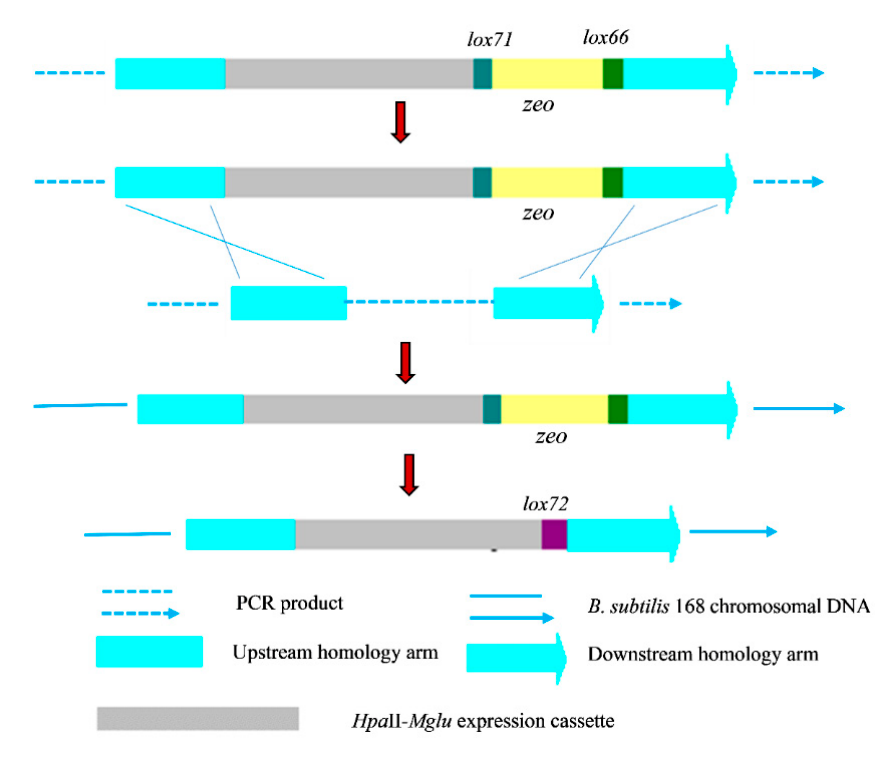
Figure 7. Strategy for integrating the Mglu gene in the B. subtilis 168 chromosome. An integrative fragment contained the lox71 - zeo - lox66 cassette with two regions having homology to the B. subtilis 16 chromosome and the Hpa II- Mglu cassette. Due to the homologous regions that flank the lox71 - zeo - lox66 cassette and the Hpa II- Mglu cassette, the corresponding gene in the B. subtilis 168 chromosome DNA can be disrupted, and the zeo gene and Hpa II- Mglu cassette is introduced. Next, the zeo gene was deleted through recombination between the lox71 and lox66 sites using the Cre/lox system, yielding the lox72 site.